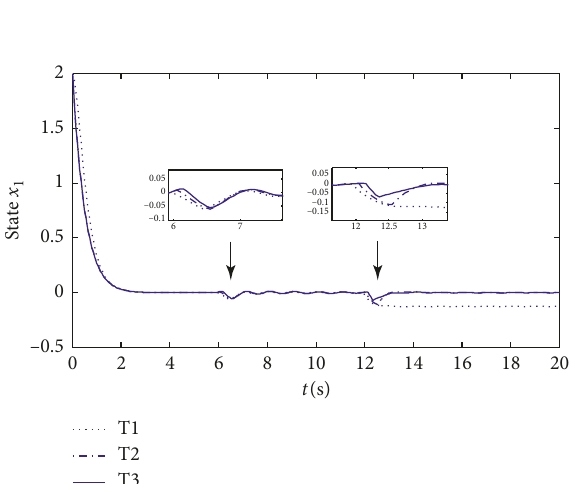
Figure 4: Response curve of state x